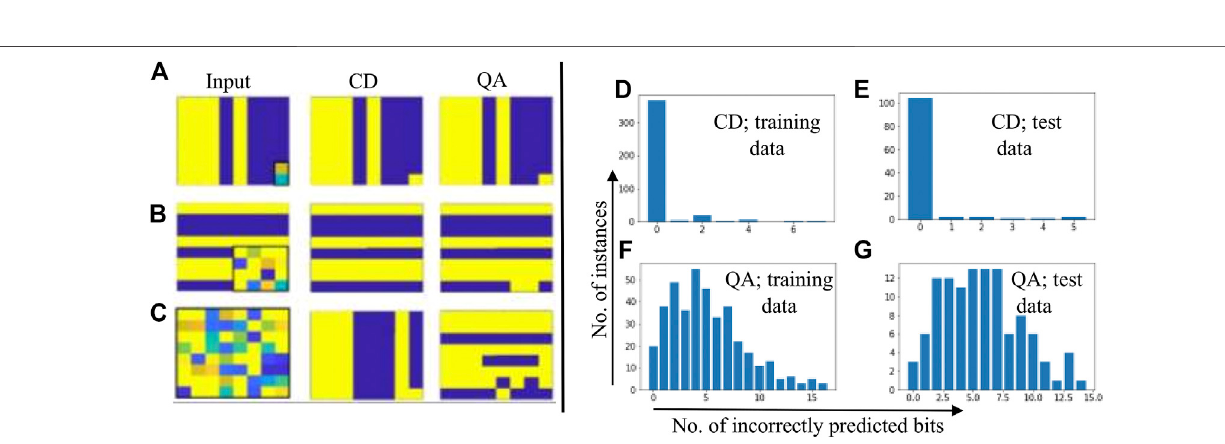
Frontiers in Physics |